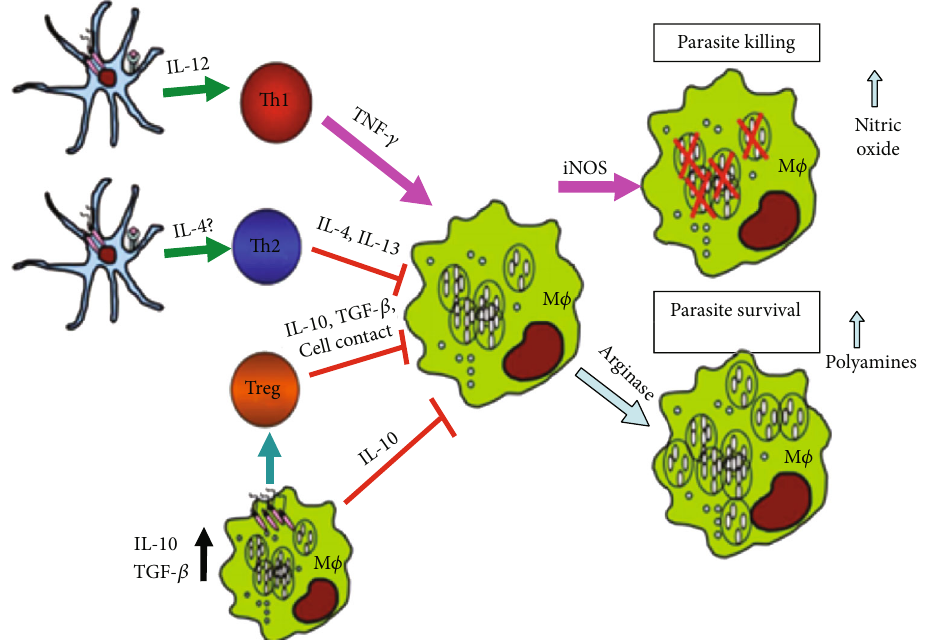
Figure 1: Dendritic cells and macrophages regulate the outcome of Leishmania infection (source: Liu and Uzonna, 2012).